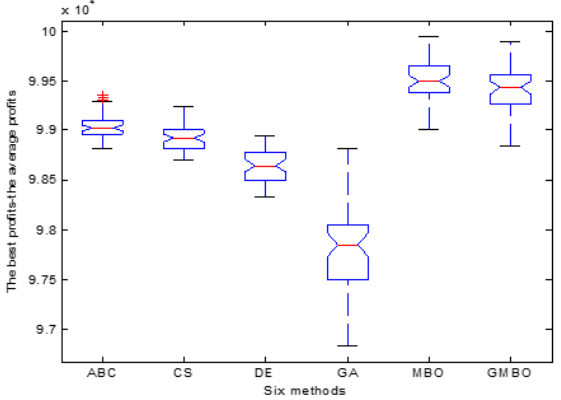
Figure 14. Boxplot of the best values on KP5 in 50 runs.